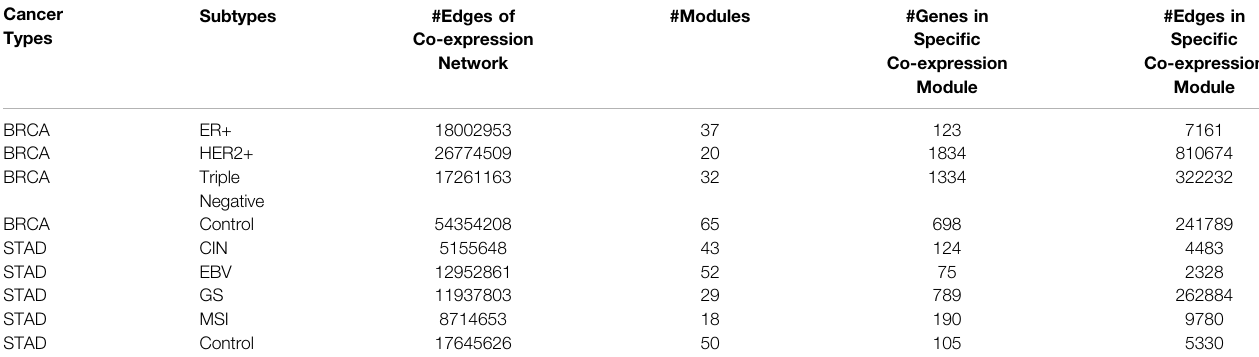
TABLE 1 | Statistics of co-expression modules of each cancer subtype.